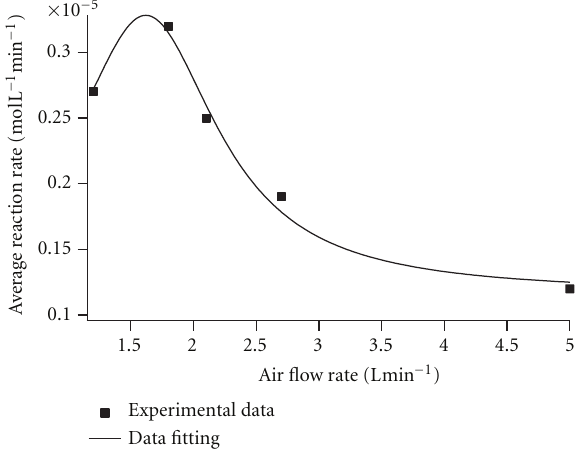
Figure 6: E ff ect of air flow rate on average reaction rate (TOC initial concentration = 24 . 62 ± 0 . 44 mgL − 1 , average reaction tem- perature = 27 ◦ C, initial slurry pH = 3 . 00,0 . 07 gL − 1 catalyst loading and 4.4 Lmin − 1 slurry flow rate).